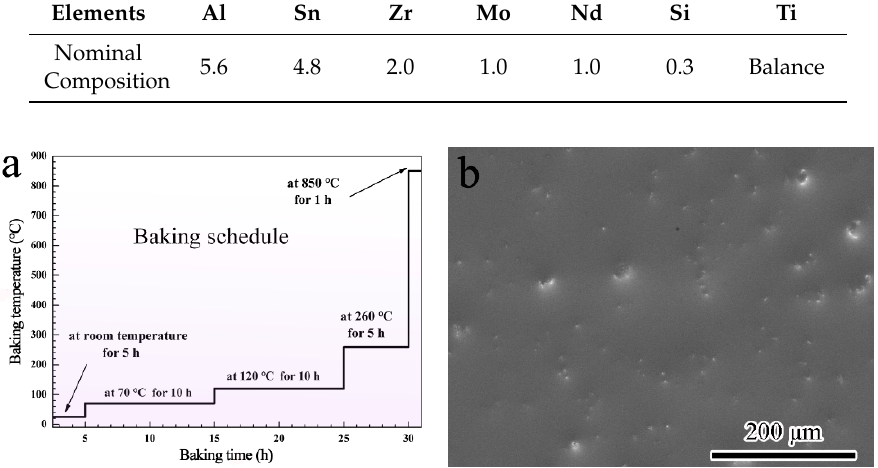
Table 1. Nominal composition of the substrate (wt.%).